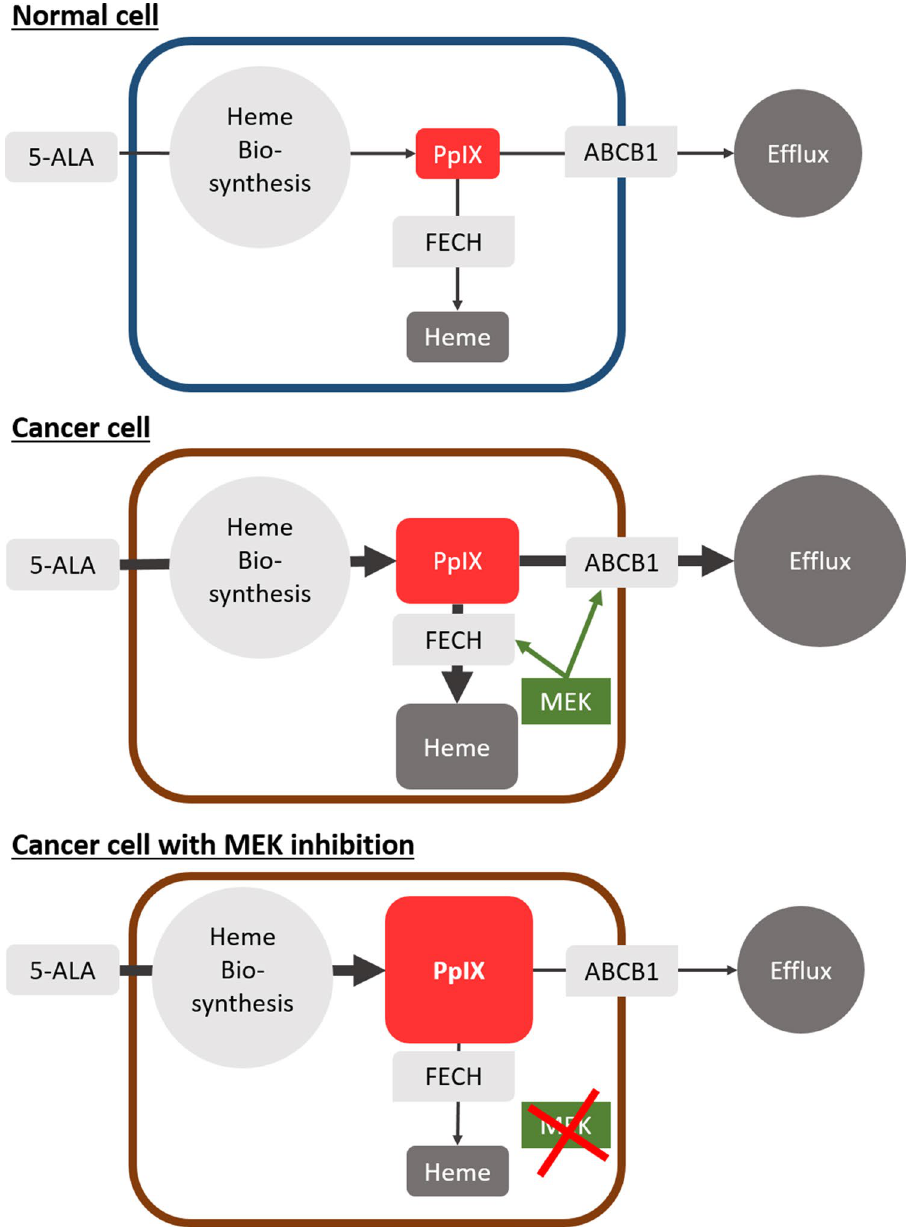
Figure 1. Schematic representation of protoporphyrin IX (PpIX) generation in normal and cancer cells. Upon exogenous stimulation with 5-ALA, cells generate PpIX via the haem biosynthesis pathway. PpIX is subsequently converted to haem by FECH or transported outside the cells through efflux receptors such as ABCB1. As oncogenic transformation activates enzymes of the haem biosynthesis pathway, cancer cells generate PpIX more efficiently than normal cells. As the Ras/MEK pathway promotes PpIX conversion to haem and PpIX efflux through ABCB1, MEK inhibition further enhances PpIX accumulation in cancer